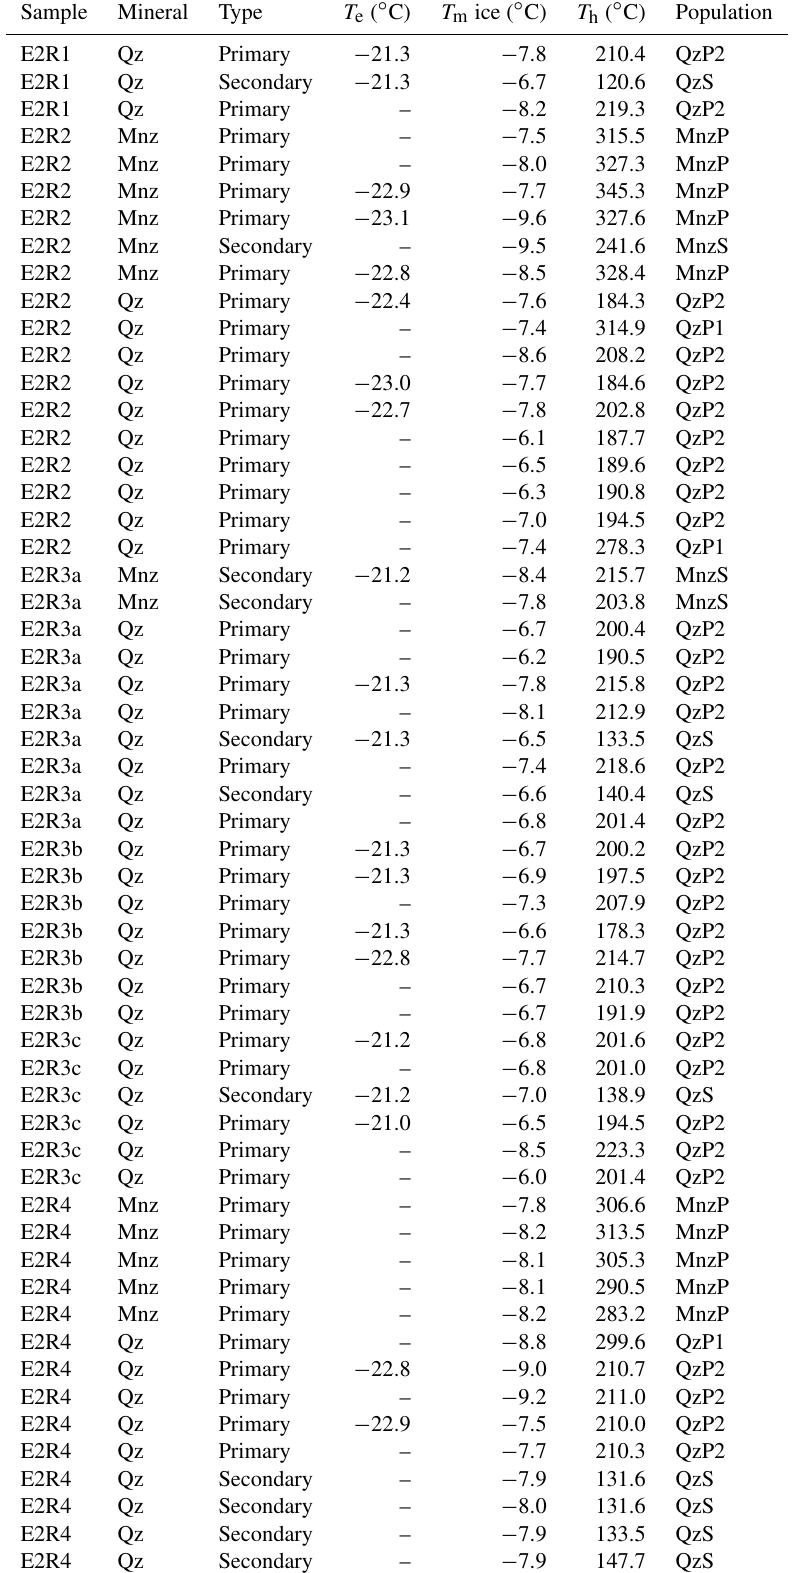
Table 1. Microthermometric analyses of fluid inclusions in monazite (Mnz) and quartz (Qz).